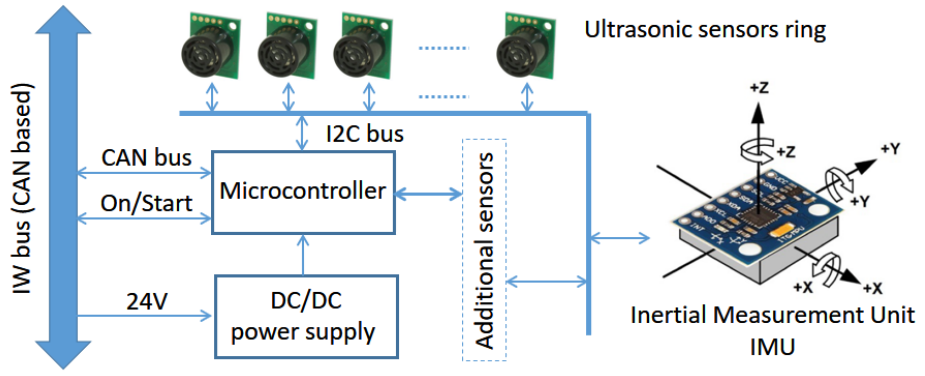
Figure 9. Block diagram of the sensor node, showing the ultrasonic ring and